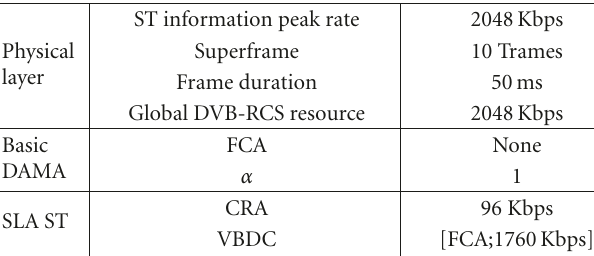
Table 1: Basic physical and MAC layer